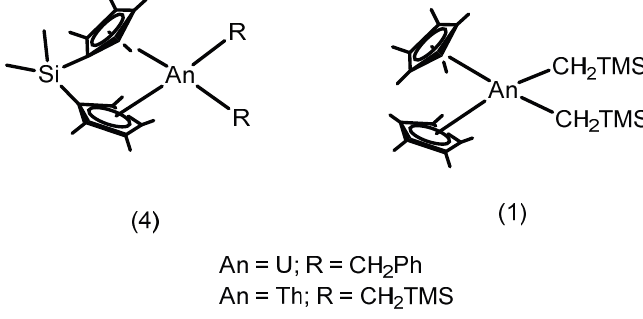
Figure 2. Actinide catalysts 4 and 1 used in the catalytic hydrothiolation of terminal alkynes [45–47].